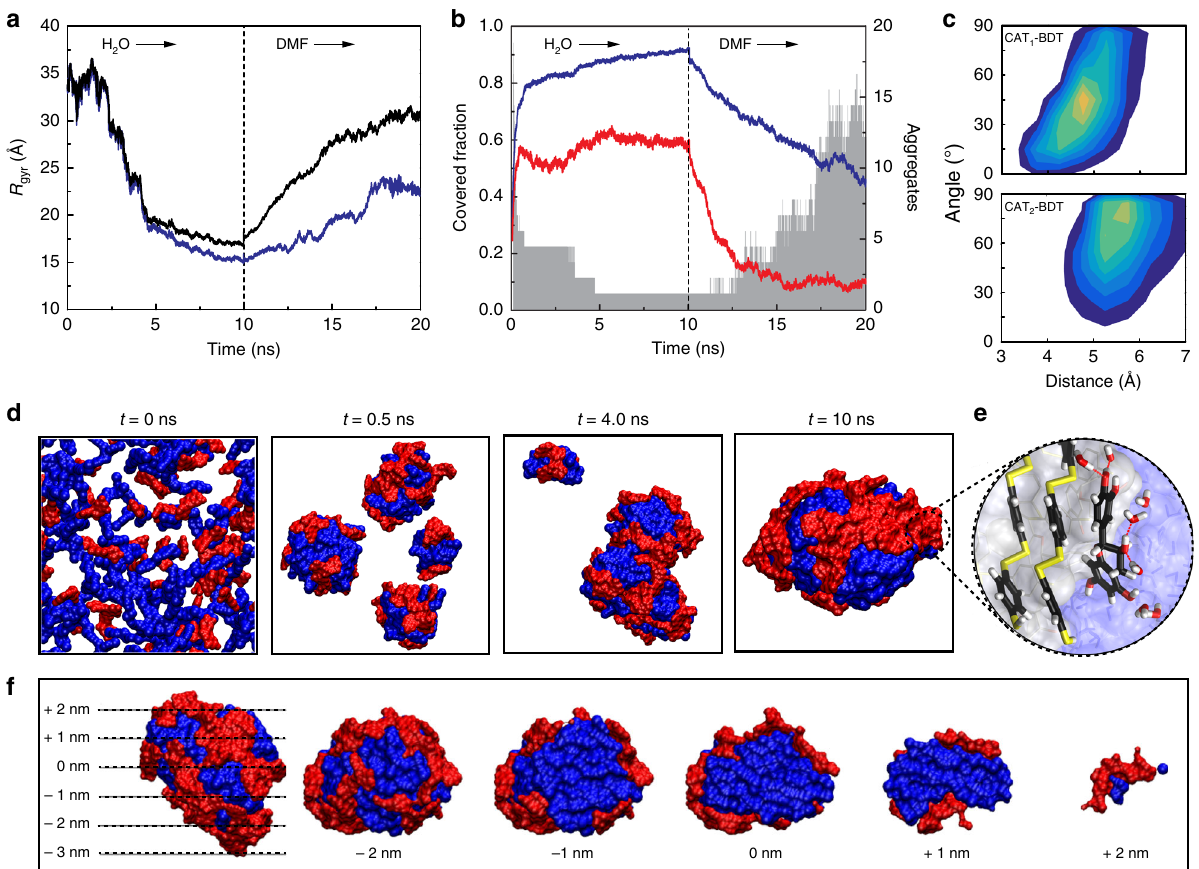
Fig. 3 All-atom MD simulation of the assembly and disassembly of pBDT and CAT in water and DMF, respectively. a Radius of gyration ( R gyr ) of pBDT (blue) and pBDT – CAT (black). b Covered fraction (namely the fraction of molecules not accessible to the solvent) of pBDT (blue) and CAT (red) molecules, and number of pBDT aggregates (gray). c Population distribution of the angle and distance between the plane of the aromatic group of each CAT molecule and a BDT aromatic ring. d Evolution pro fi les of the size of the complex, comprised of pBDT (blue) and CAT (red), showing aggregates at 0, 0.5, 4.0, and 10 ns of MD simulation in water. MD snapshot of the largest formed single aggregate at 10 ns. e Magni fi ed interface section showing molecular details of aromatic stacking of BDT and CAT and hydrogen bonding between CAT and water; carbon, oxygen, hydrogen, and sulfur are colored black, red, white, and yellow, respectively, and hydrogen bonds are represented by thin red lines. f Cross-sectional images of the pBDT – CAT complex after 10 ns of MD simulation in water highlighting the pBDT core (blue) and CAT shell (red). 0 nm indicates the center of mass of the complex in the vertical direction (left snapshot) and cross-sections rotated 90° are shown within the − 2 to 2 nm